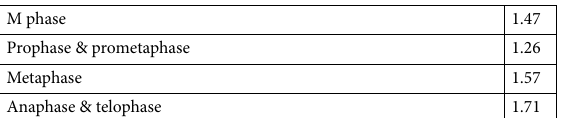
Table 1. Ratios of mean duration of totasl M phase and different sub-phases in SIRT6 overexpressing/control cells.